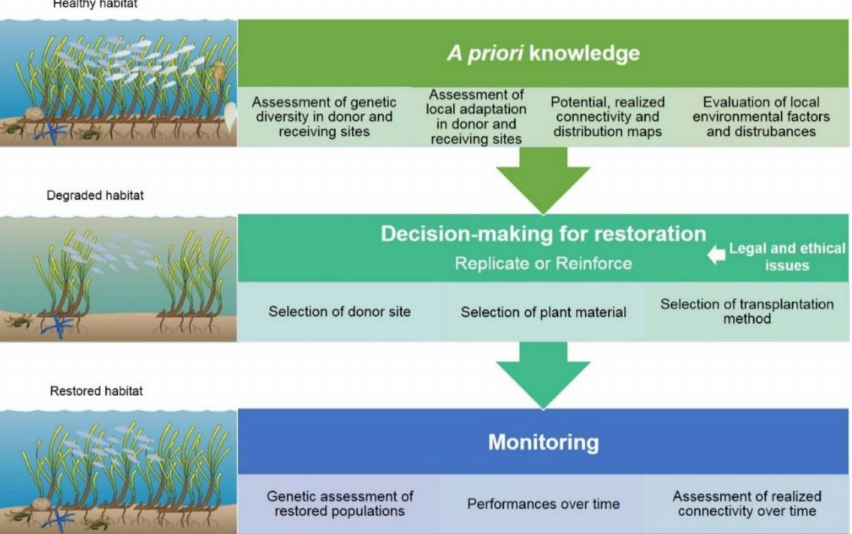
Figure 1. Diagram showing different aspects of seagrass restoration. The restoration plan should include different steps. The “a priori” knowledge includes the assessment of genetic diversity and local adaptation in donor and receiving sites. Moreover, maps of potential and realized connectivity and the evaluation of local environmental status over the whole distribution area of the species are necessary to have a comprehensive baseline to perform a successful restoration plan and to select suitable donor sites. The restoration itself can be aimed to either replicate or reinforce genotypes in target sites and can be performed with different plant material and thorough different restoration methods (always according to the evaluation of legal and ethical issues). In order to assess the restoration success, genetic traits (diversity and connectivity) and performances (physiological, de- mographic, and growth traits) of newly established meadows must be monitored over time. Symbols were taken from courtesy of the Integration and Application Network, university of Maryland center for environmental science (http://ian.umces.edu/symbols/ accessed on 10 March